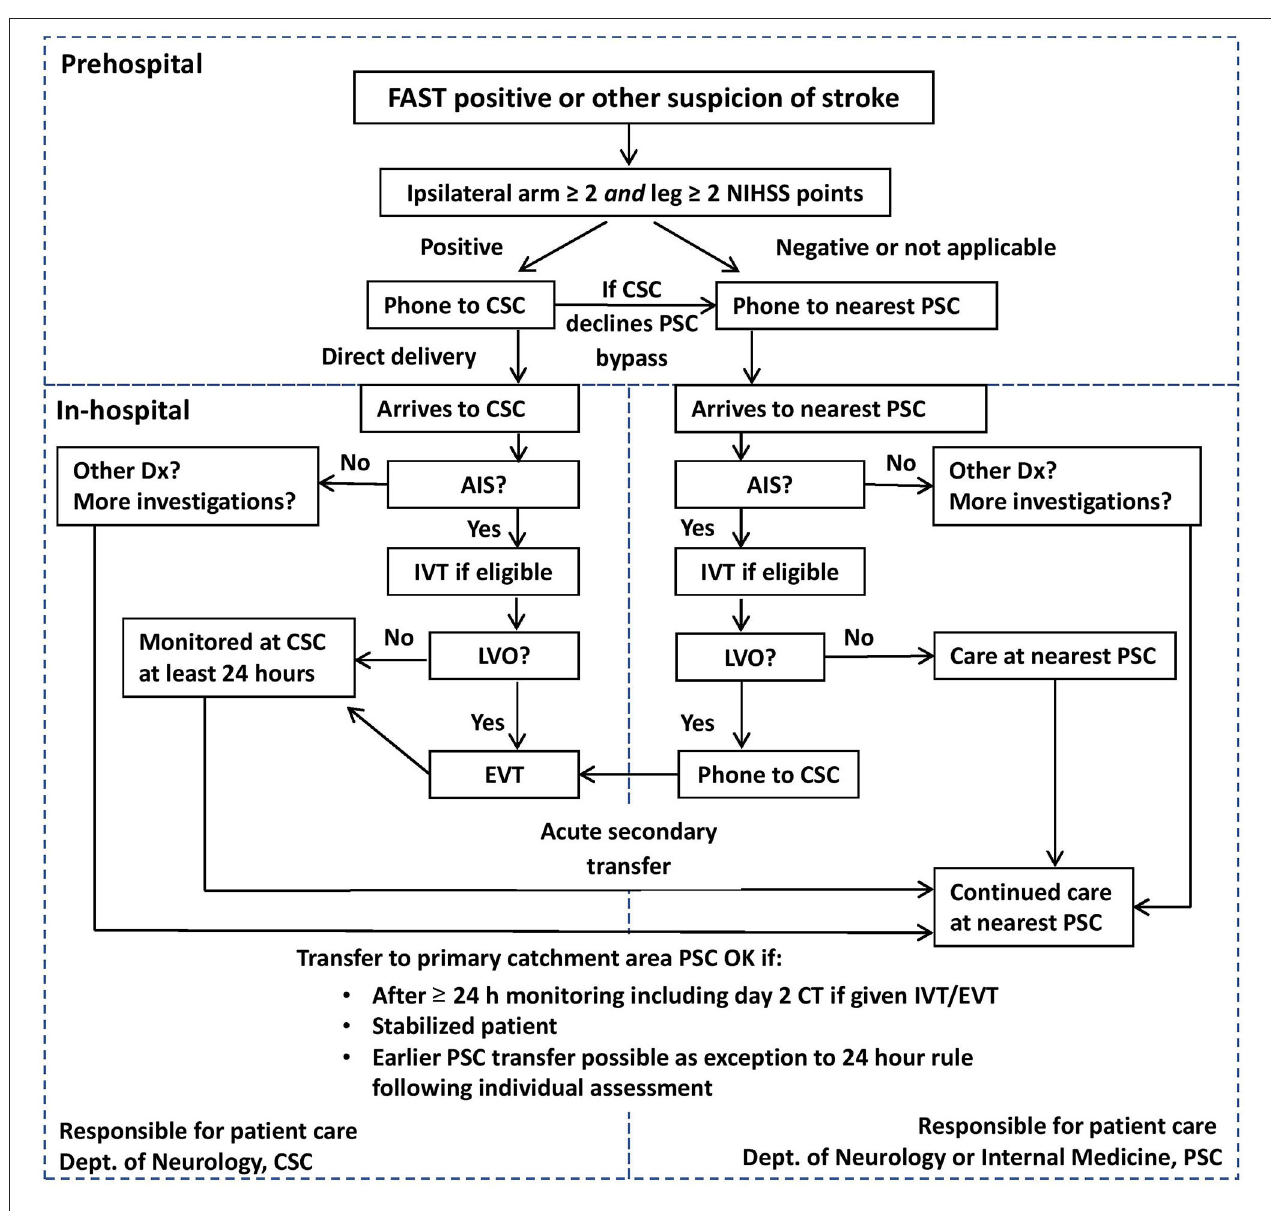
FIGURE 1 | Flowchart of the Stockholm Stroke Triage